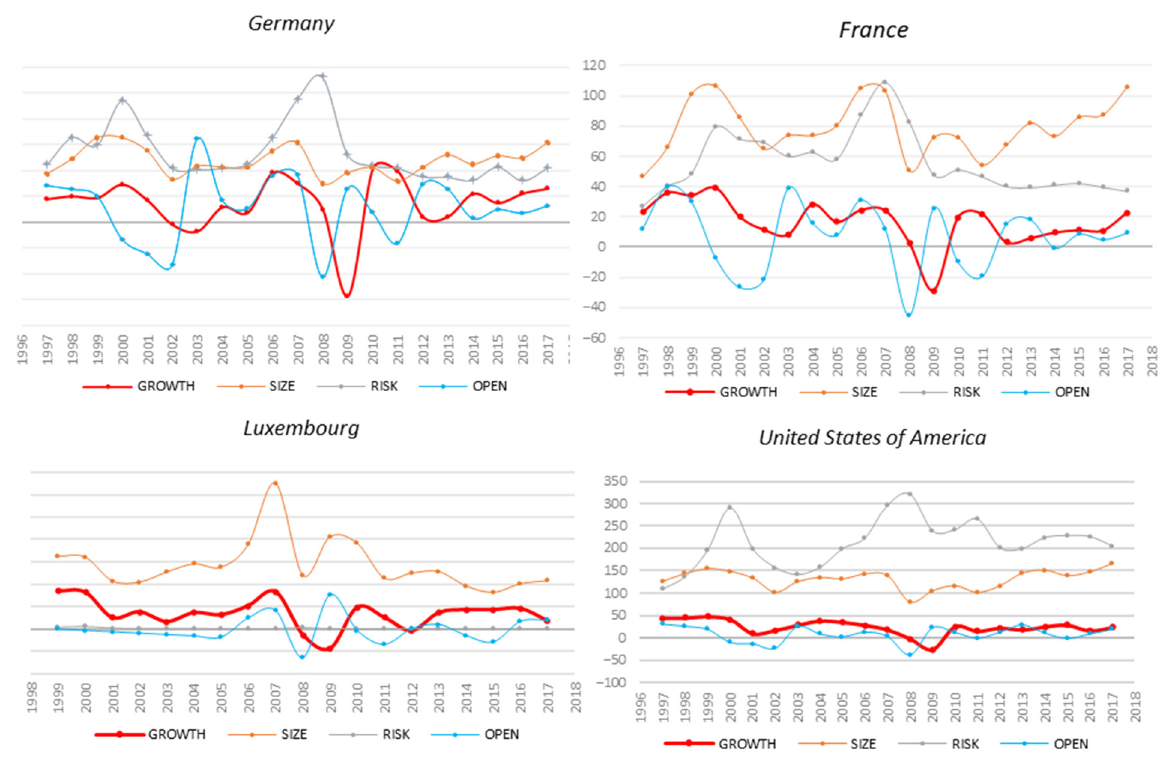
Figure 1. Evolution of economic growth and size, risk diversification, and openness of the stock market in Germany, France, Luxembourg, and the U.S.A.